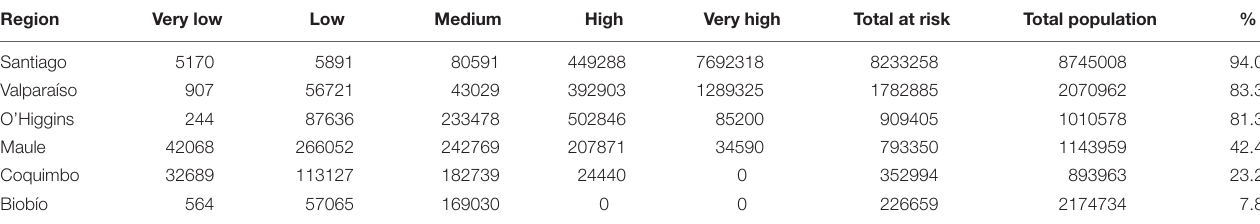
TABLE 1 | Population per risk level and region in Chile. Region